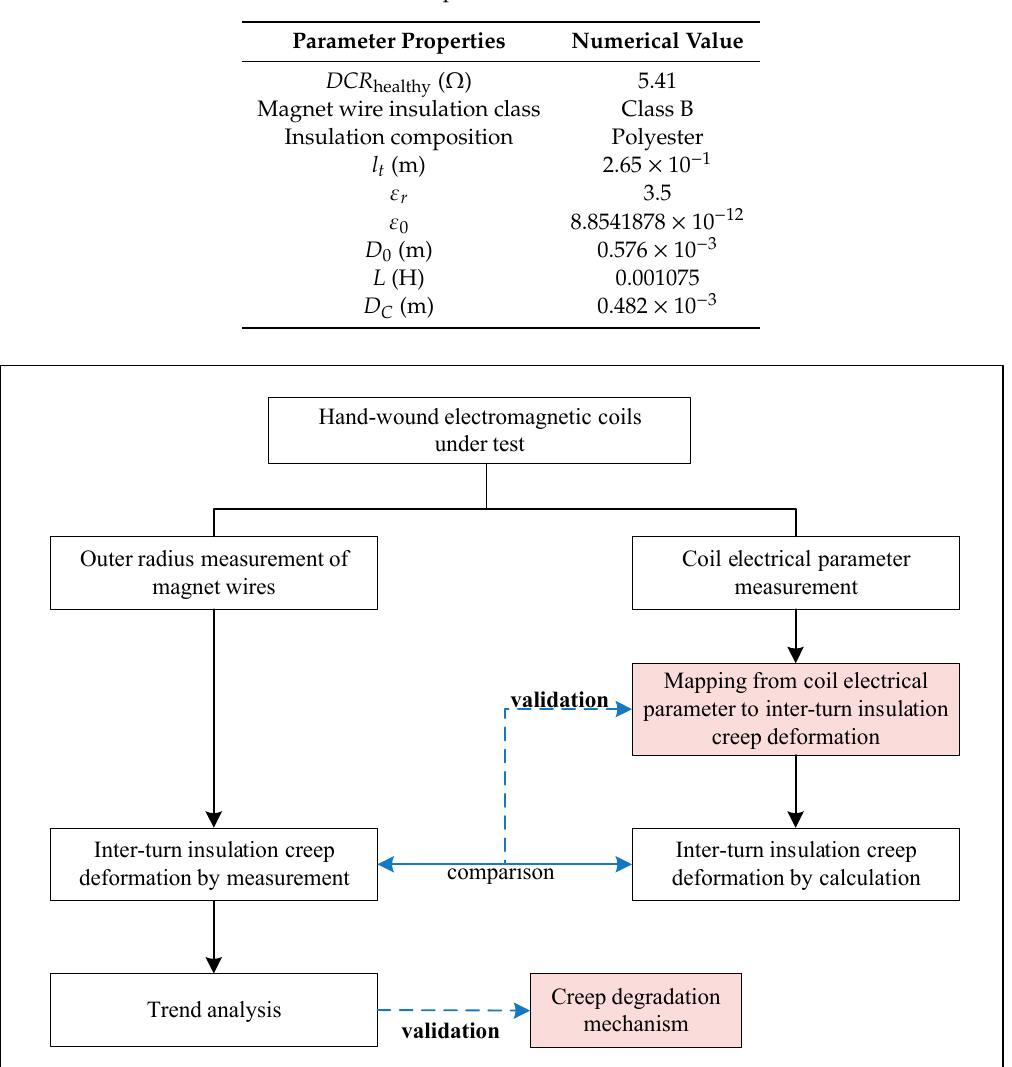
Table 1. Specimen information.